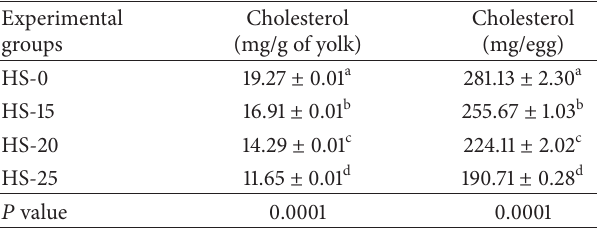
Table 2: Mean ± SE of cholesterol contents in eggs from hens consuming different levels of hemp seed ( 𝑛 = 3